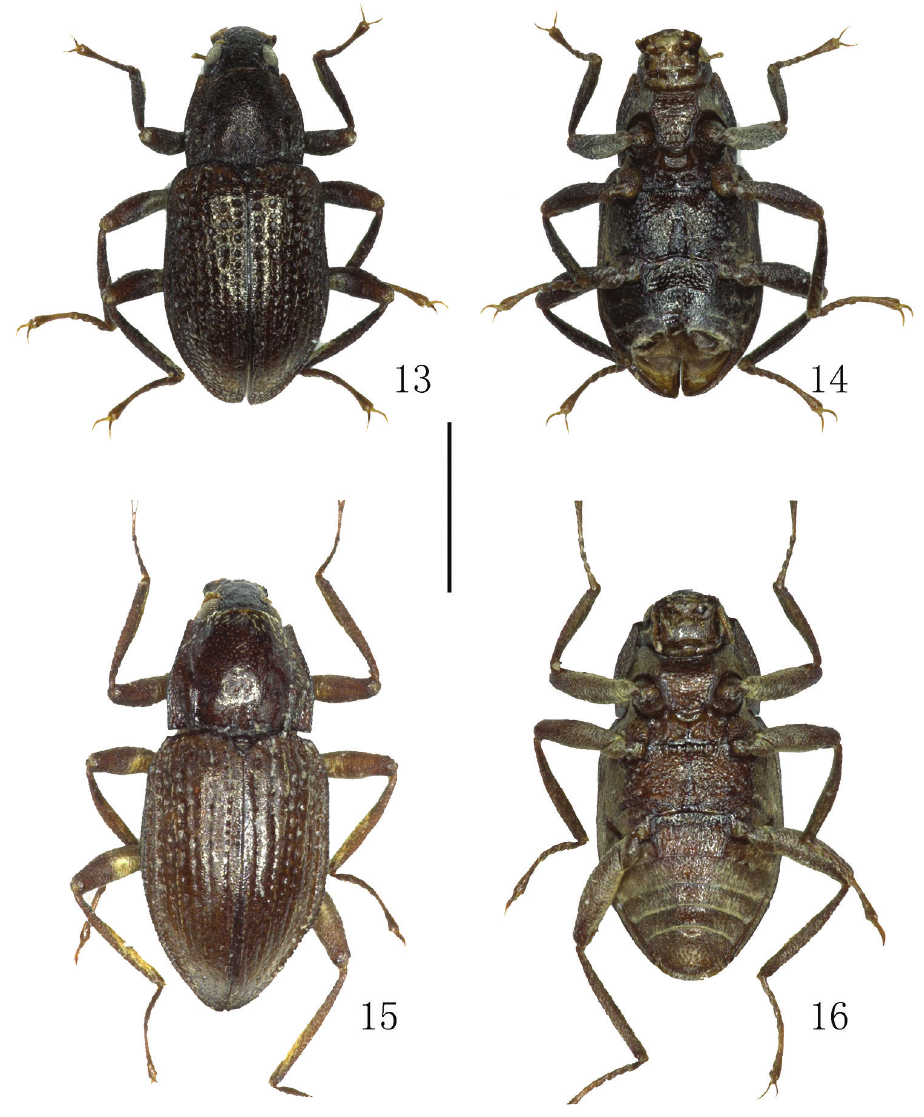
Grouvellinus sinensis Grouvelle, 1906: 126. TL: China, Yunnan. Distribution. China: